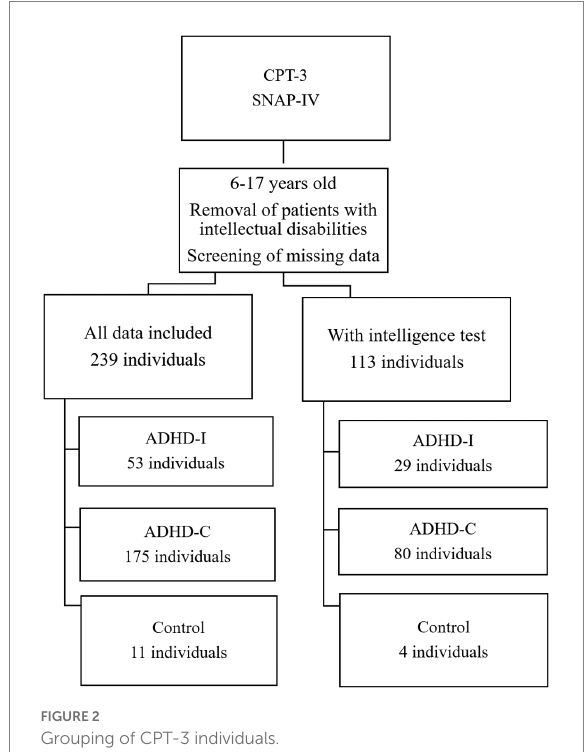
FIGURE 2 Grouping of CPT-3